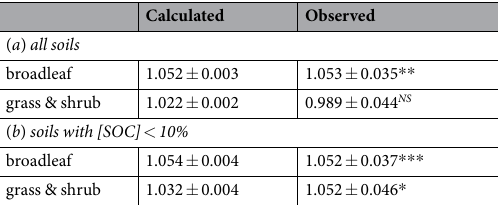
Table 3. Calculated and observed values of R SF , the ratio of the soil organic carbon (SOC) concentration at the second sampling to that at the first, with 95% confidence intervals intervals, for topsoils of Great Britain, based on sampling between 1959 and 2010 (Table 1). For the observed ratios, significant difference from 1.0 is indicated: NS not significant, * P ≤ 0.05, ** P ≤ 0.01, *** P ≤